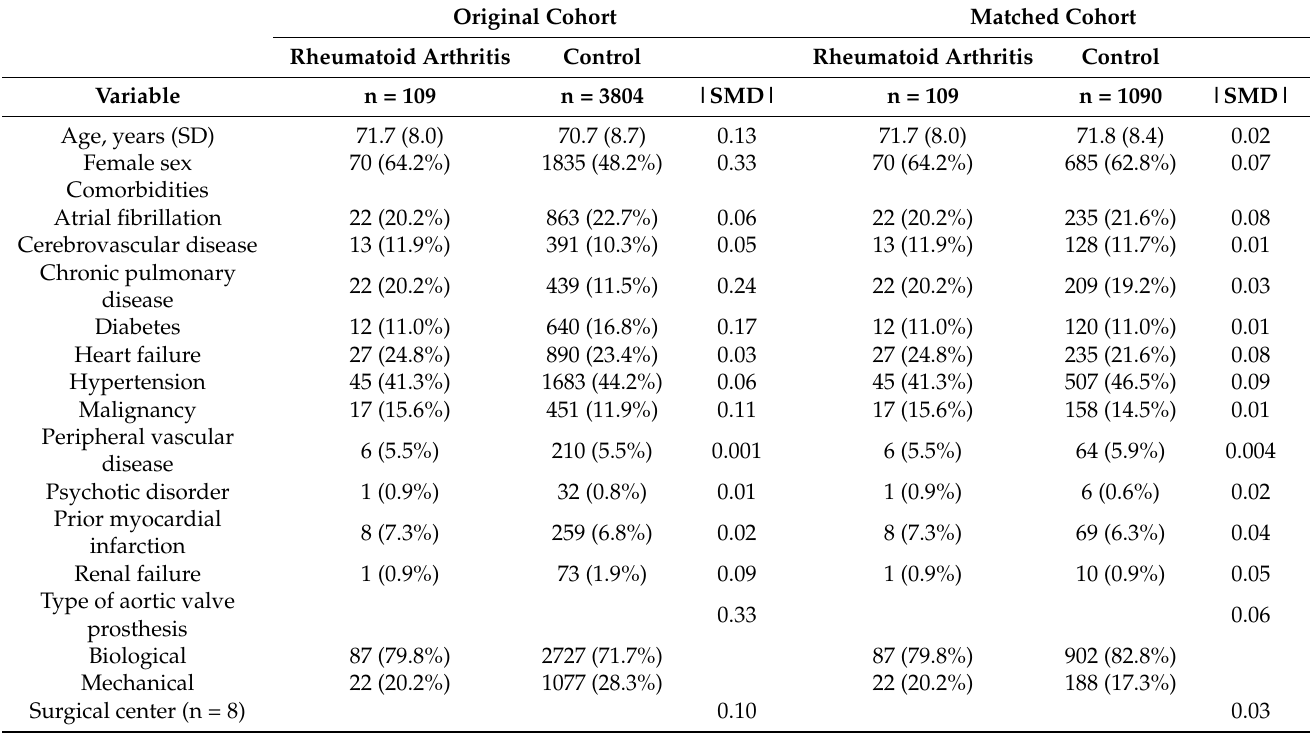
Table 1. Baseline features of rheumatoid arthritis and control patients with isolated surgical aortic valve replacement for aortic stenosis. All and propensity score matched patients. SMD = Standardized mean